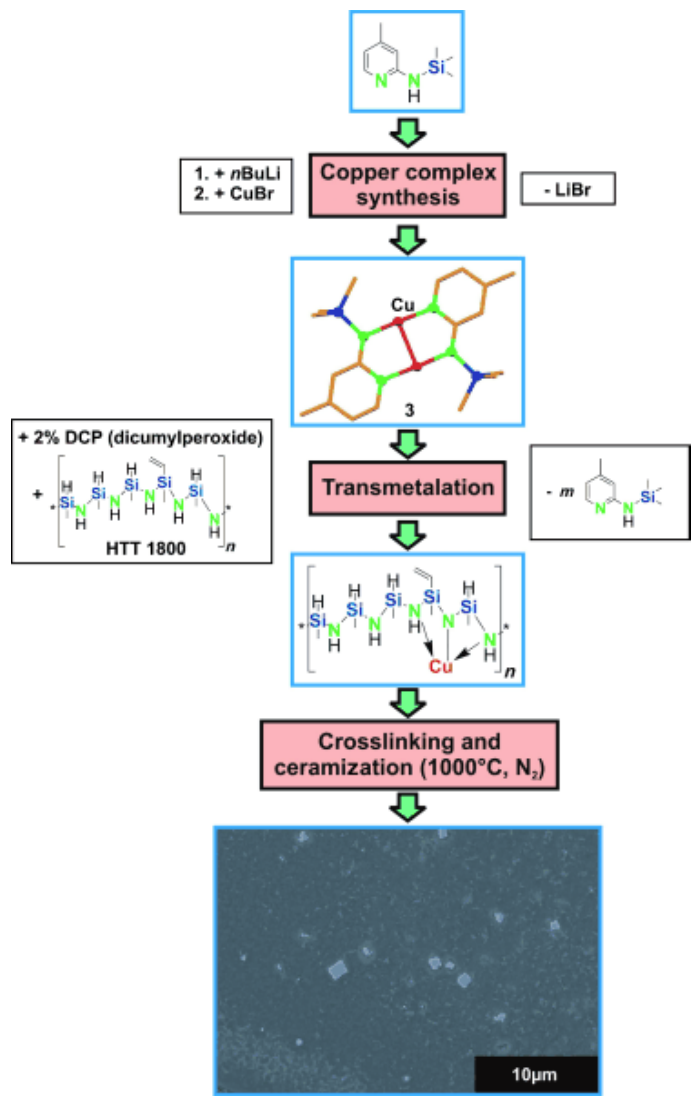
Figure 5. Modification of HTT1800 with an aminopyridinato copper complex leading to Cu-containing SiCN ceramics by pyrolysis to 1000 °C under nitrogen (with permission from Wiley)